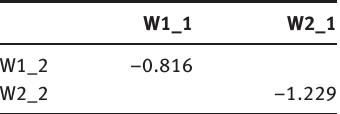
Table 4. Critical Ratios for Differences Between